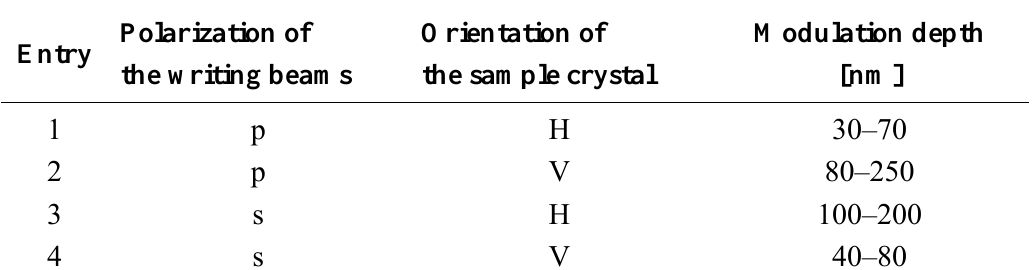
Table 1. Modulation depth of SRG inscribed on the AAB crystal by irradiation with writing beams (5 mW  2) for 20 min.